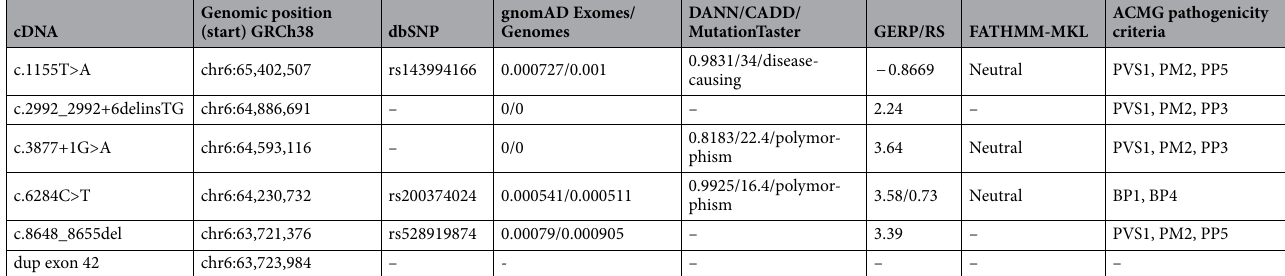
Table 2. Characterization of EYS variants identified in arRP cohort from northern Sweden. All sequence positions are denoted according to NM_001142800.1) (GRCh38/hg38 human reference genome). dbSNP –database of single nucleotide variations at https:// www. ncbi. nlm. nih. gov/ snp/. gnomAD-genome aggregation database at https:// gnomad. broad insti tute. org/. DANN/CADD-prediction tools for annotating of pathogenicity (Quang et al. 2015; Rentzsch et al. 2019) MutationTaster predicts a disease-causing potential of single nucleotide polymorphism (Schwarz et al. 2014). GERP-Genomic Evolutionary Rate Profiling (GERP) is a conservation score across alignments of the genomes of 35 mammals (Cooper et al. 2005). FATHMM-MKL represents normalized functional predictions from numerous non-synonymous computational predictions algorithms (Shihab et al. 2017). ACMG- standards and guidelines for the interpretation of sequence variants recommended by the American College of Medical Genetics and Genomics (Richards et al.